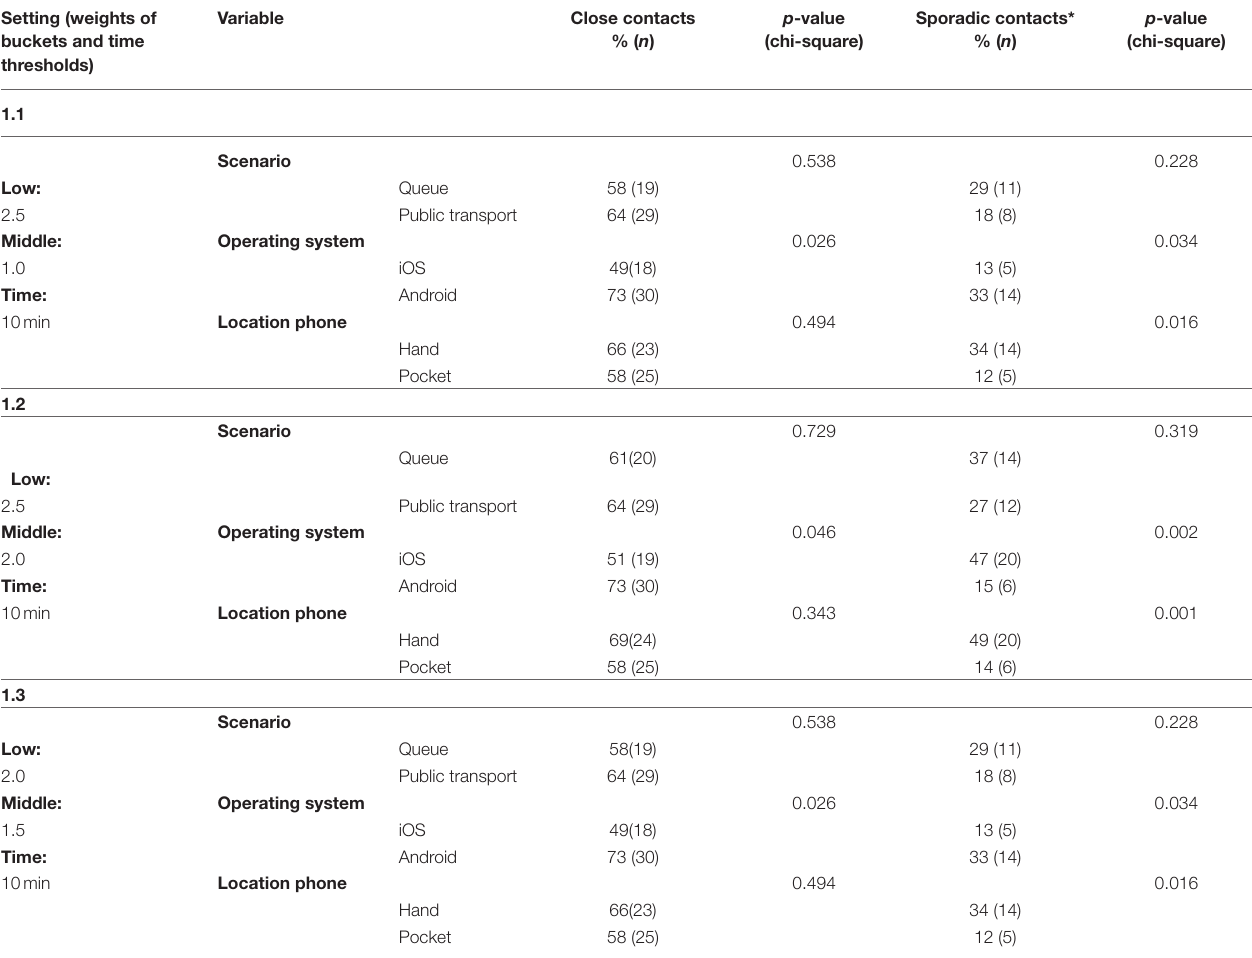
TABLE 2 | Notification rates among close contacts and sporadic contacts using configuration #1 with selected weights split by various variables. Setting (weights of buckets and time